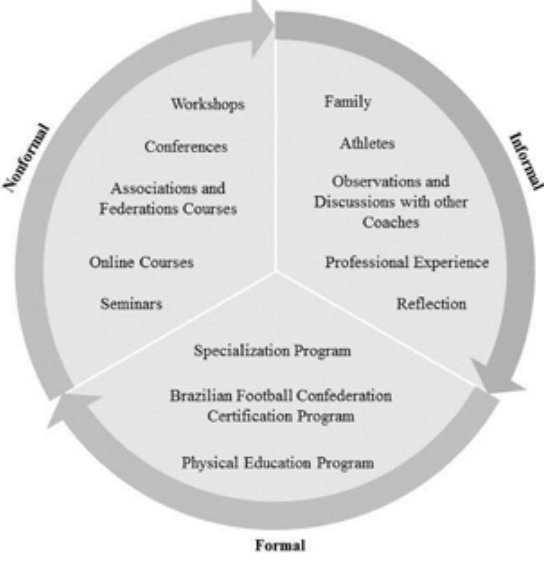
Figure 2 Contexts and episodes of coach learning (adapted from Nelson, Cushion and Potrac 6